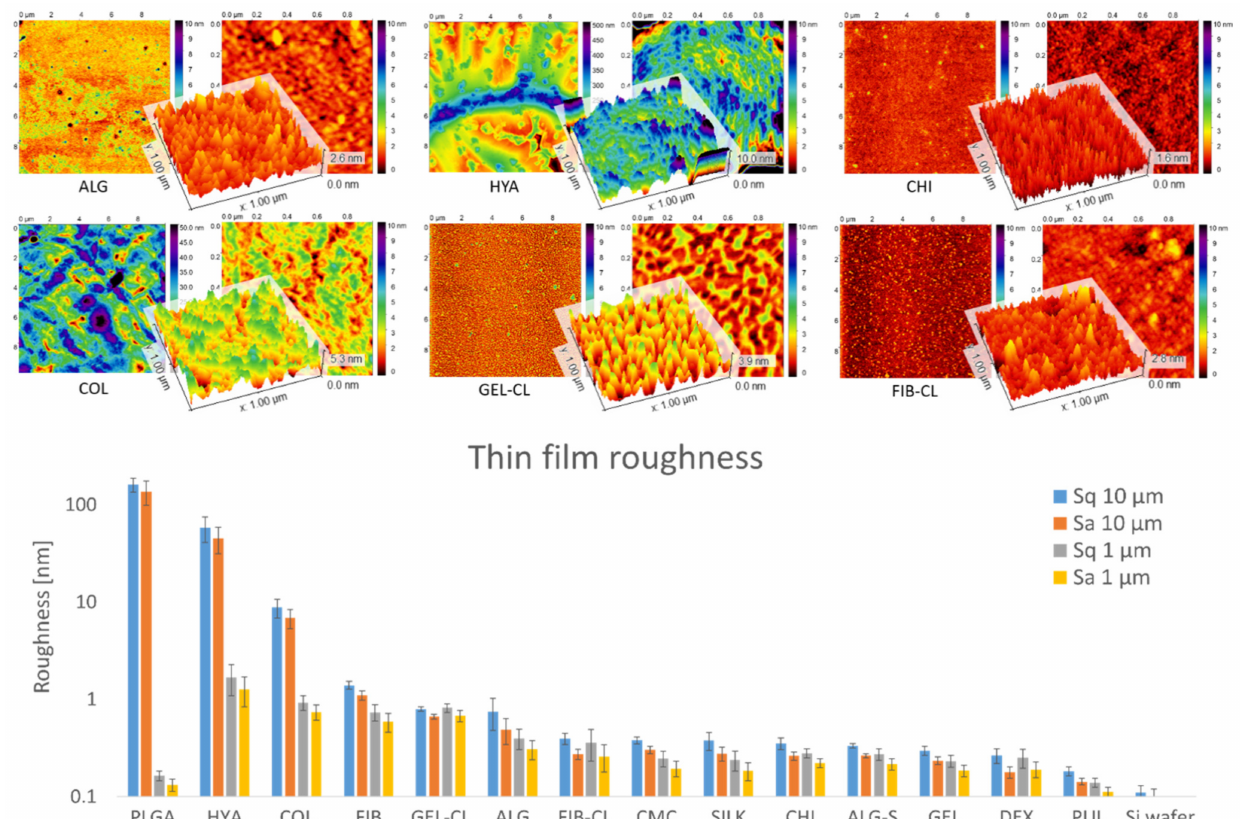
Figure 2. Results of AFM analysis. The calculated roughness values (Sq and Sa of 10 × 10 and 1 × 1 µ m scans) of all prepared thin films are shown in the chart ( bottom ), as well as micrographs of ALG, HYA, CHI, COL, GEL-CL, and FIB-CL thin films ( top —the remaining micrographs are available in the Supplementary Material, Figures S2.1 and S2.2). For each sample, areal scans of 10 × 10 µ m (left) and 1 × 1 µ m (right) are shown, with a 3D render ( middle ). The height variation of most polymers lies within the 0–10 nm range, except for collagen (0–50 nm), and hyaluronic acid and PLGA (in the 0–500 nm